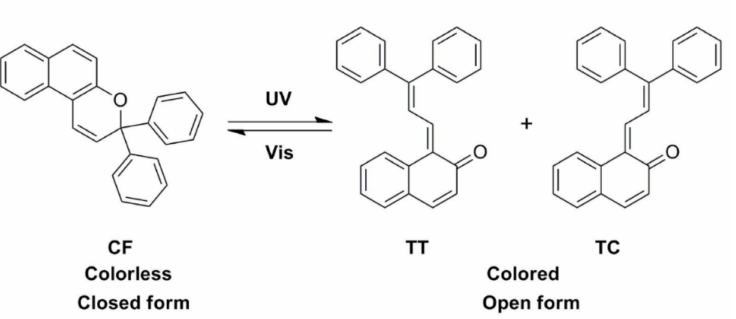
Figure 9. Reversible structural transformation of 3,3-diphenyl-3H-naphtho[2,1-b] pyran (NP) under UV and visible light.